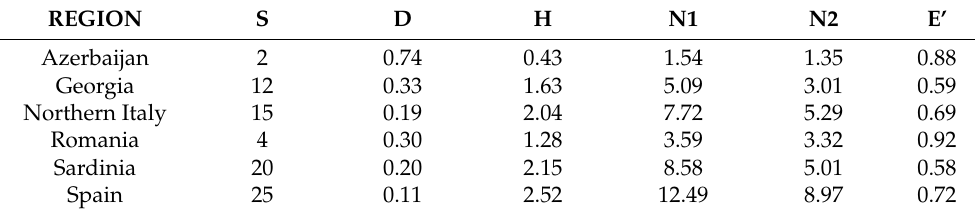
Table 1. Ecological index analysis grouping the six regions (S = species richness; D = Simpson’s index; H = Shannon’s index; N1 = Hill’s abundant species index; N2 = Hill’s very abundant species index; E’ = Hill’s evenness